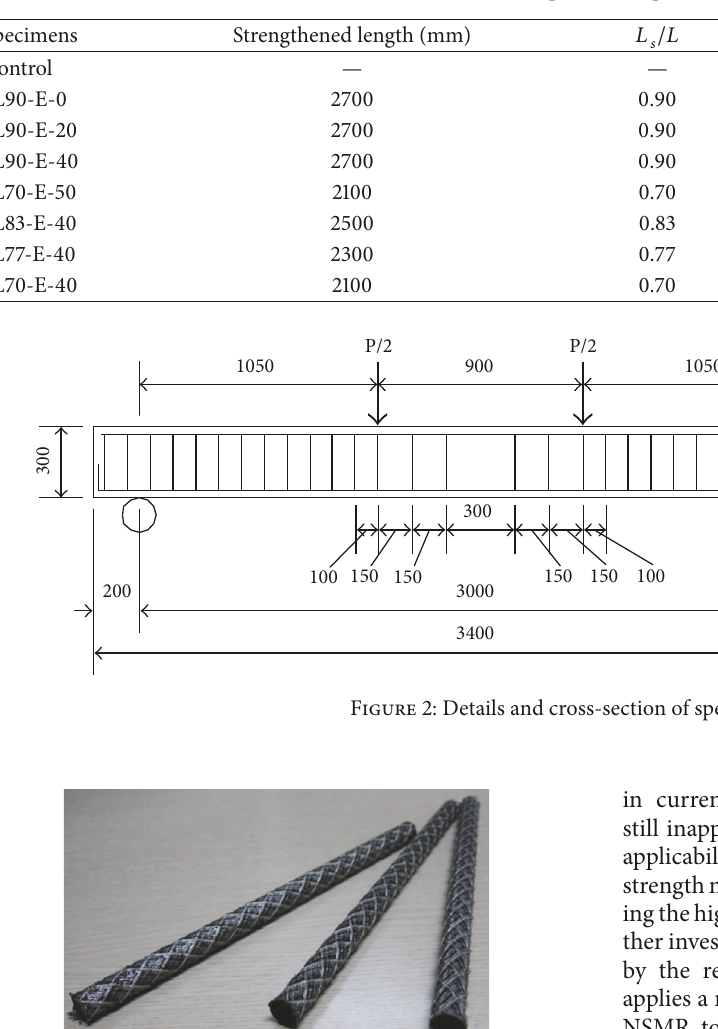
Table 2: Experimental parameters.